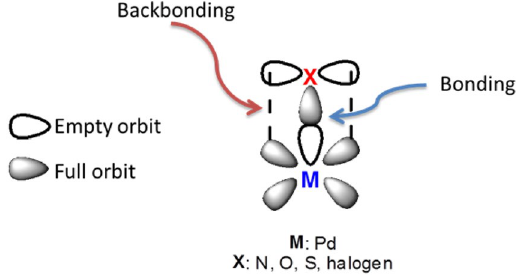
Figure 5. Bonding and back bonding between metal-ligand.